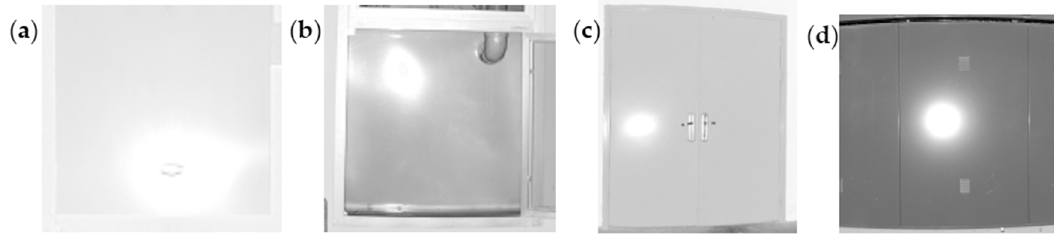
Figure 6. Original intensity images: ( a ) polyvinyl chloride sheet; ( b ) paint steel plate; ( c ) polished aluminum alloy door; ( d ) rubber advertising board.